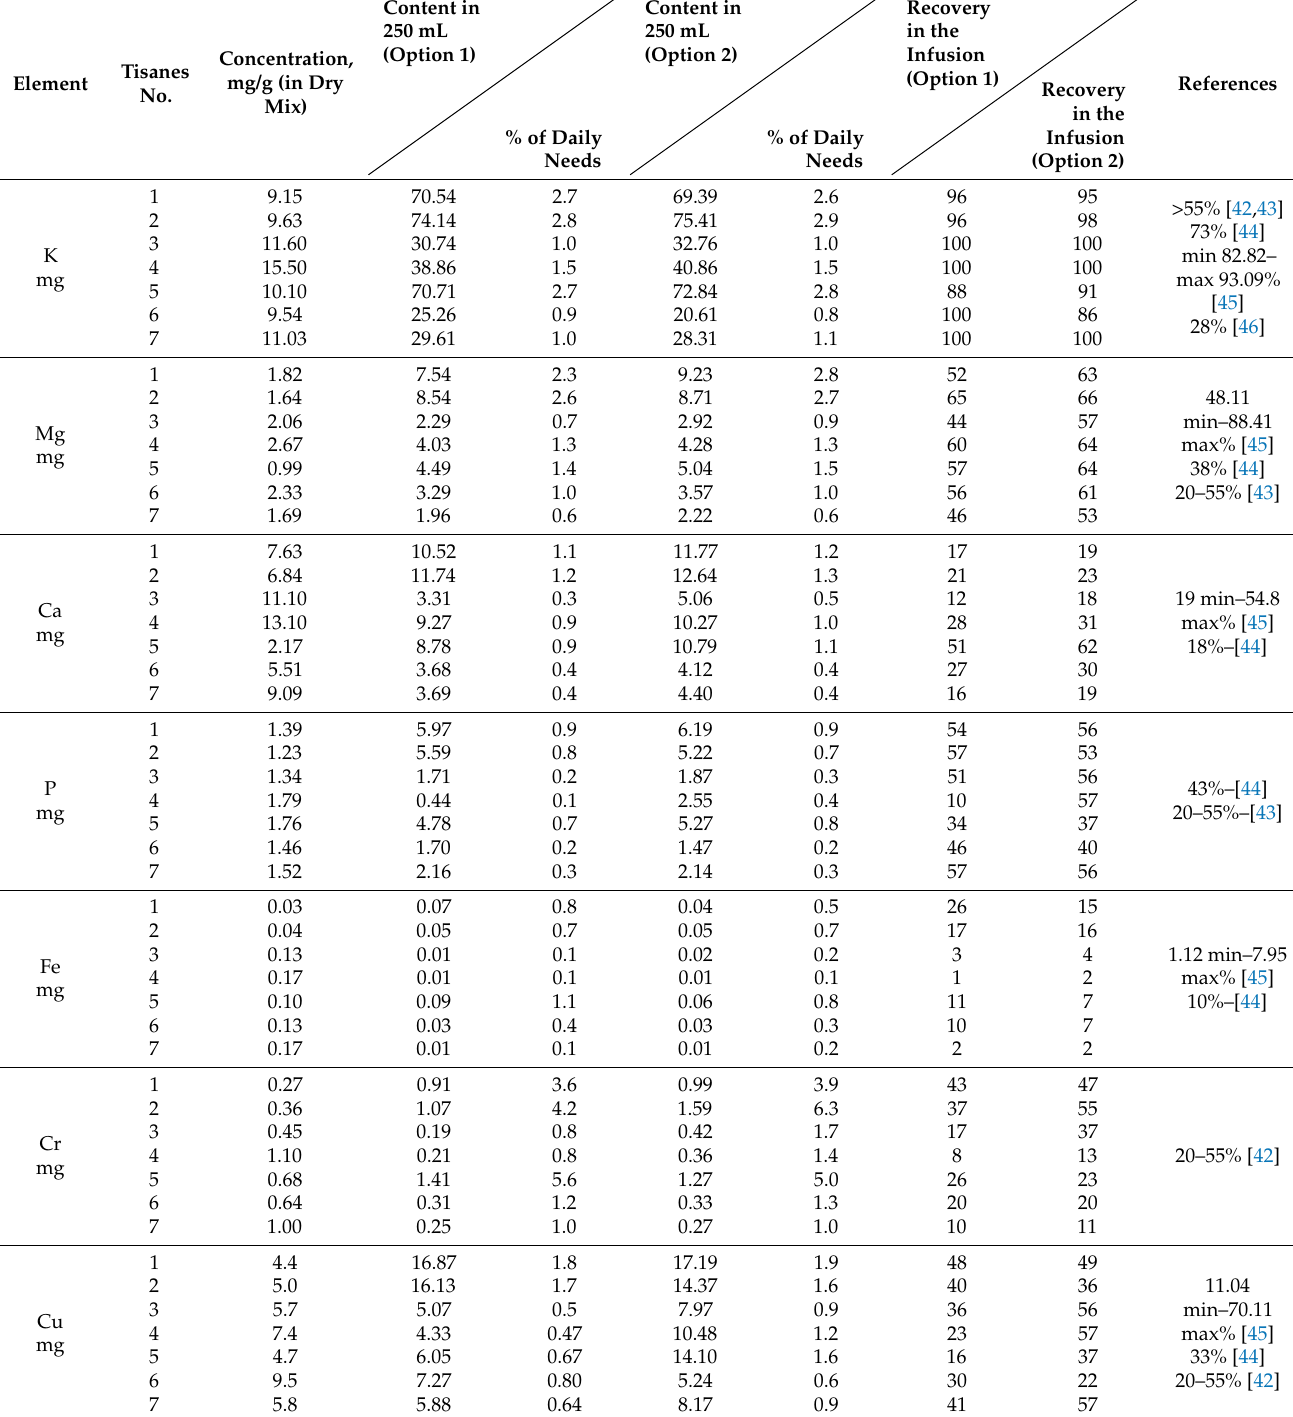
Table 8. Characteristics of essential